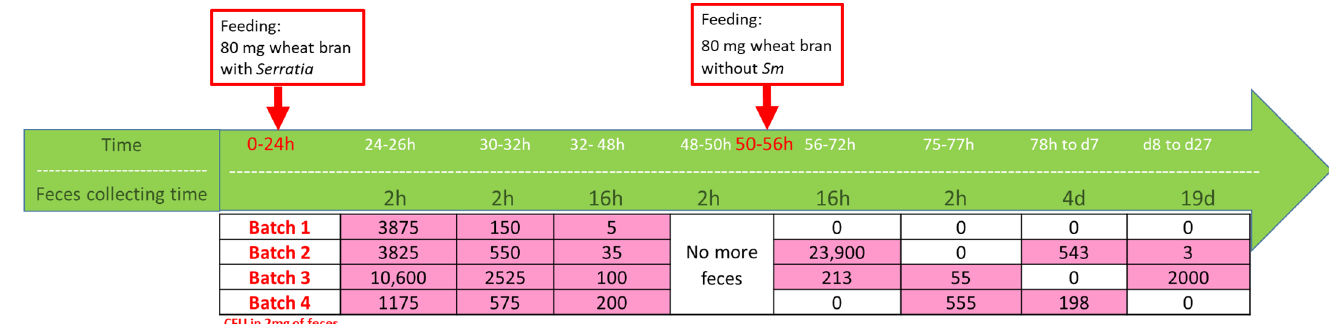
Figure 7. The kinetics of the presence of Serratia marcescens (Sm ) in Tm feces. The numbers are Sm